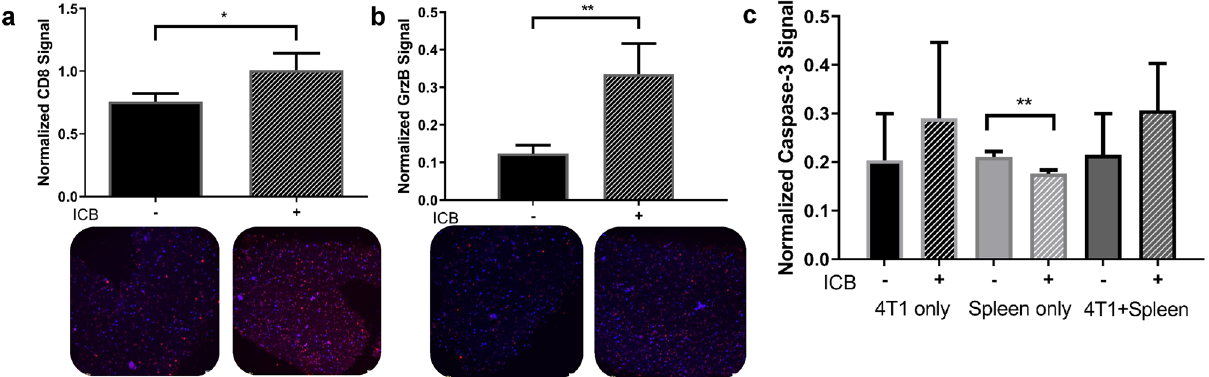
Figure 4. The effects of ICB on immune cell cytotoxicity in iTOs. ITOs were treated with anti-CTLA-4 and anti-PD-1, ICB combination, as indicated, and analyzed for CD8, granzyme B, and cleaved caspase 3 expression with immunostaining. ( a , b ) DAPI normalized CD8-positive ( a ) and granzyme B-expressing ( b ) cell numbers are significantly increased by ICB administration in iTOs. (p = 0.0158 and 0.0024 for CD8 and granzyme B, respectively, n = 4). Representative IF images from each group are shown below. ( c ) Cleaved caspase-3 IF signal in 4T1 cell only organoids, splenocytes only organoids and iTOs, treated with ICB and untreated, as indicated (significance in splenocytes only organoids p = 0.0021) (n = 4